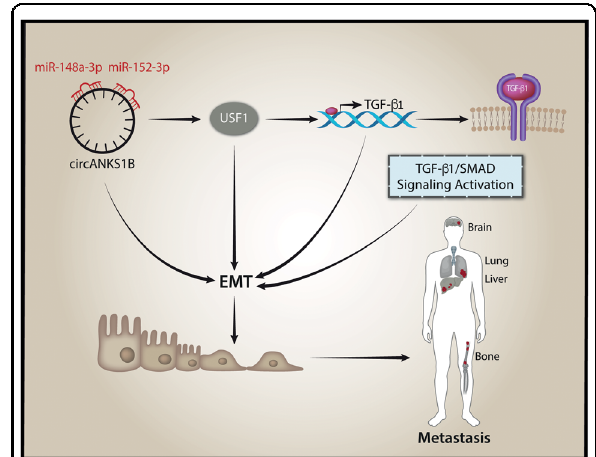
Fig. 3 circANKS1B working in the TGF- β 1 signaling pathway. CircANKS1B promotes the epithelial-to-mesenchymal transition (EMT) in triple-negative breast cancer sponging the miR-148a-3p and miR- 152-3p, enhancing the expression of transcription factor USF1 and activating the TGF- β 1/Smad signaling